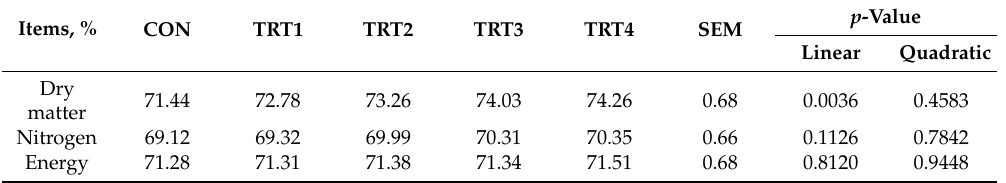
Table 3. E ff ect of coating the blend of OA and MCFA supplementation on nutrient digestibility in broilers.